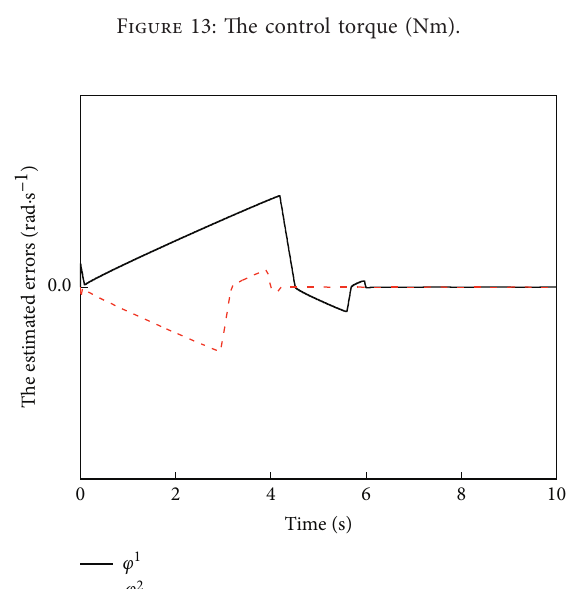
Figure 15: The trajectories of attitude angles (rad).